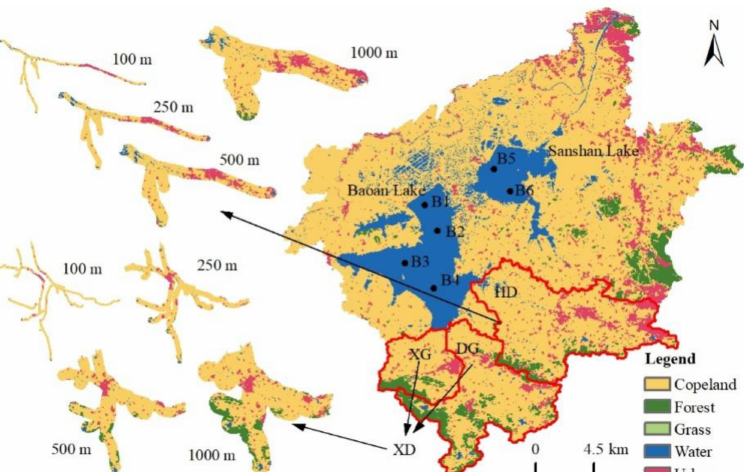
Figure 1. Overview of land use in the study area and a distribution map of the sampling locations. The main map on the right shows the scope of the Baoan Lake basin. The land in the basin is divided into five types: cropland, forest, grass, water, and urban. The water in the figure is Baoan Lake or Sanshan Lake. The scope marked by the red line on the lower side of the lake is the sub-basin selected for this study, in which Baoanxi Gang (XG) and Baoandong Gang (DG) are collectively referred to as XD. The small map on the left shows the 100–1000 m buffer zone range in the two sub-basins and its scale is consistent with the main